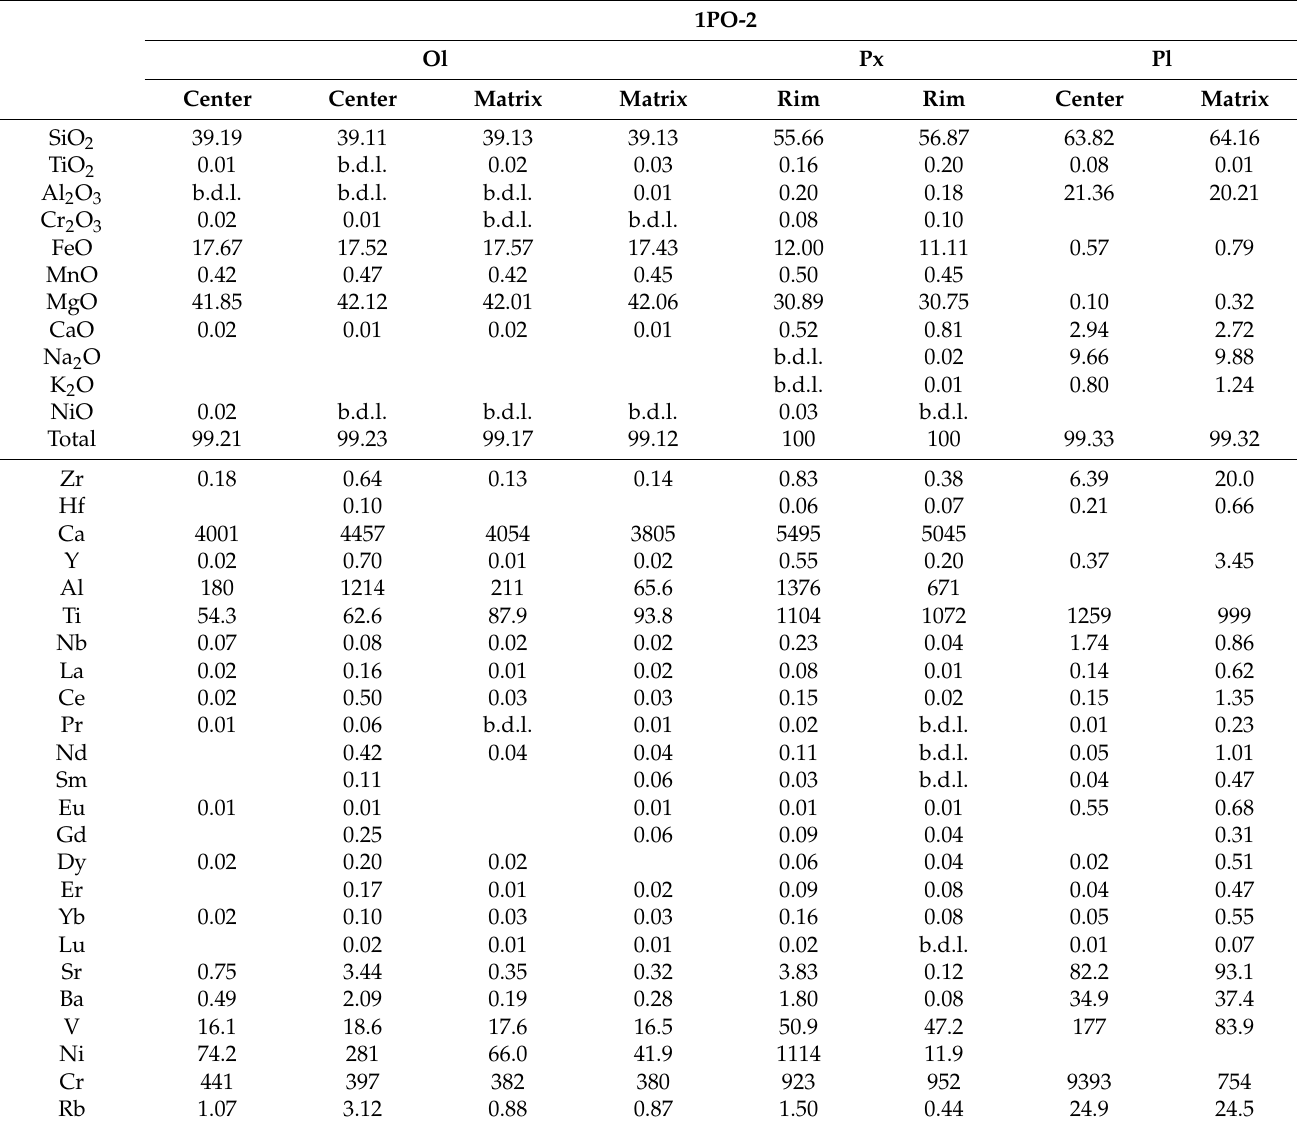
Table 3. Major (measured by EPMA, in wt.%) and trace (measured by SIMS, in ppm) elements in silicate minerals of 1PO-2 chondrule from the Kargapole